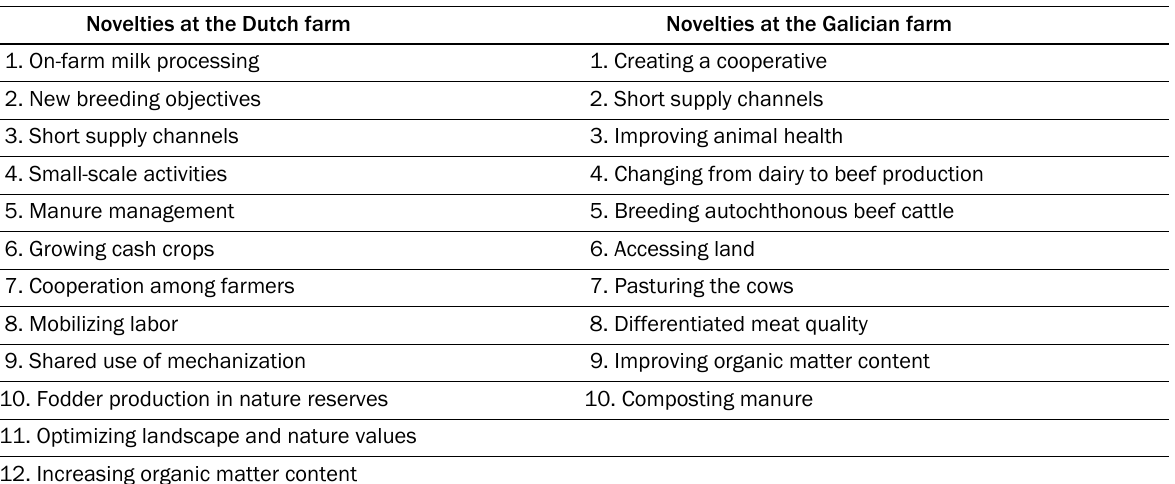
Table 1. Overview of the Novelties Developed at the Farms Novelties at the Dutch farm